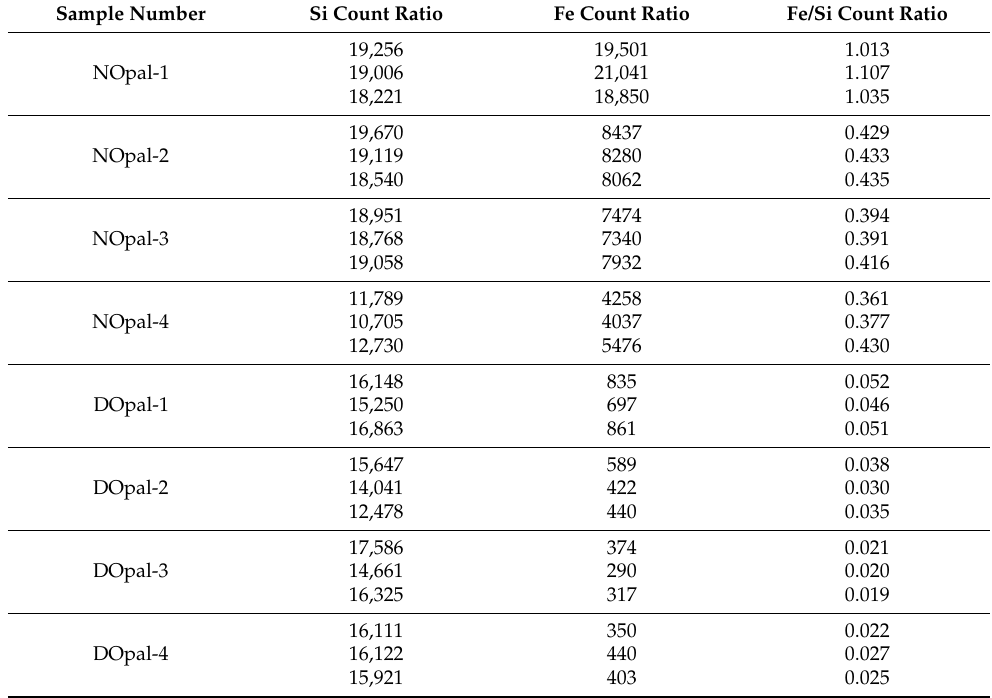
Table 5. Count ratio of Fe/Si in samples.